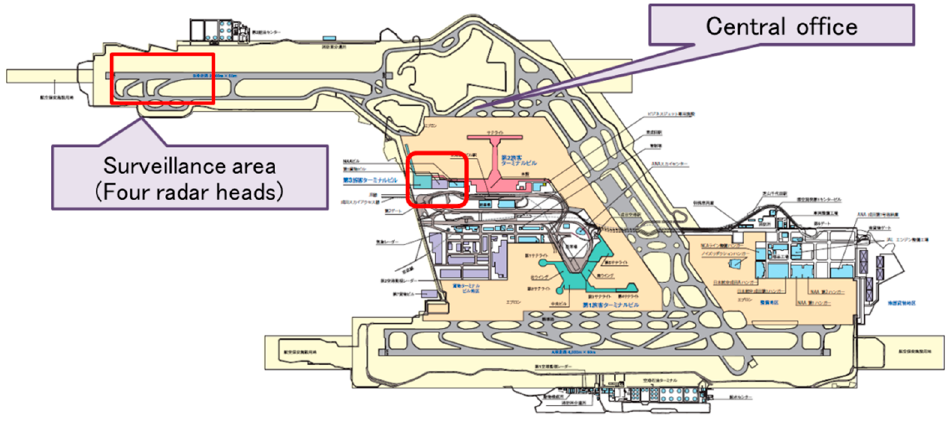
Figure 11. Field trial at Narita International Airport [6].